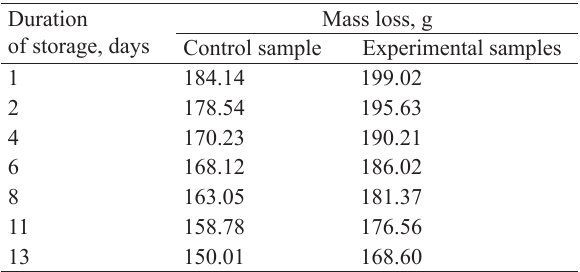
Table 4 Mass loss of cooled pork packed in biodegradable